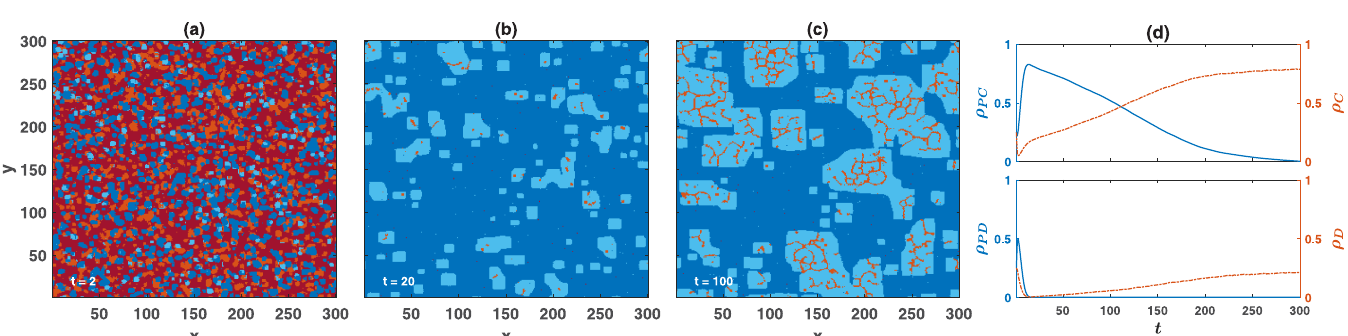
Fig 4. Time evolution of the wasteful punishment model in a structured population. (a) to (c) present the snapshots of the system’s time evolution, and (d) shows the frequency of different strategies as a function of time. Here, a population of N = 90000 individuals lives on a two-dimensional 300 × 300 lattice with periodic boundaries and Moore connectivity. Different colors indicate different strategies. Light blue shows non-punishing cooperators, dark blue shows punishing cooperators, light red shows non-punishing defectors, and dark red shows punishing defectors. The simulation started with a random initial condition. Here, ν = 10 − 3 , c = c 0 = 1, r = 4 and ρ =